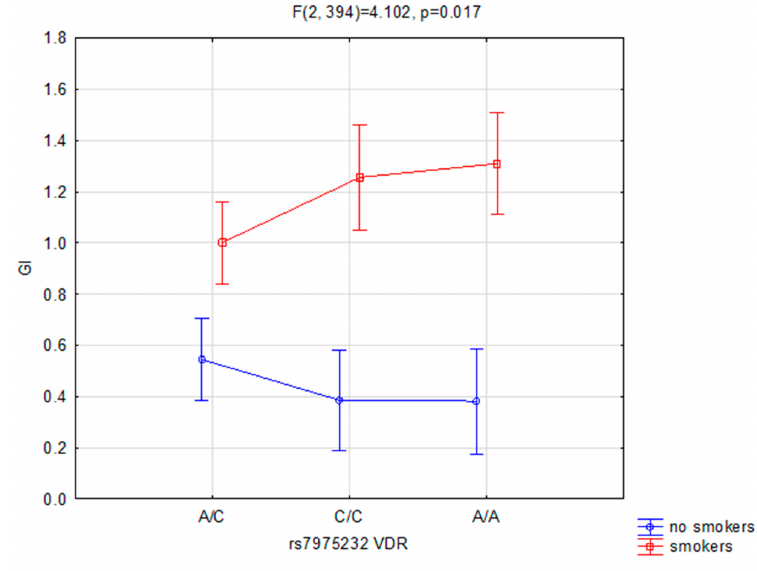
Figure 3. Interaction between smoking/non-smoking and rs7975232 and GI.